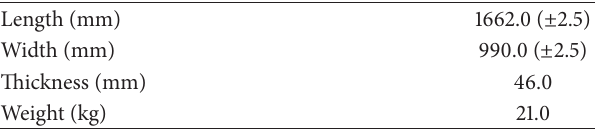
Table 1: Panel dimensions and